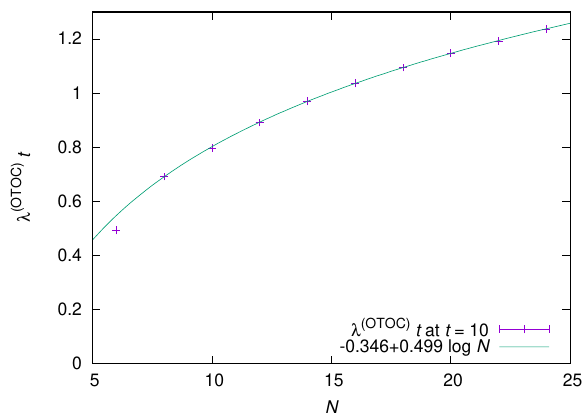
Figure 6 . Plot of the value of (cid:21) (OTOC) t at t = 10 along with a (cid:12)t with a linear function of log N for the generalized SYK model with K = 0 : 01.